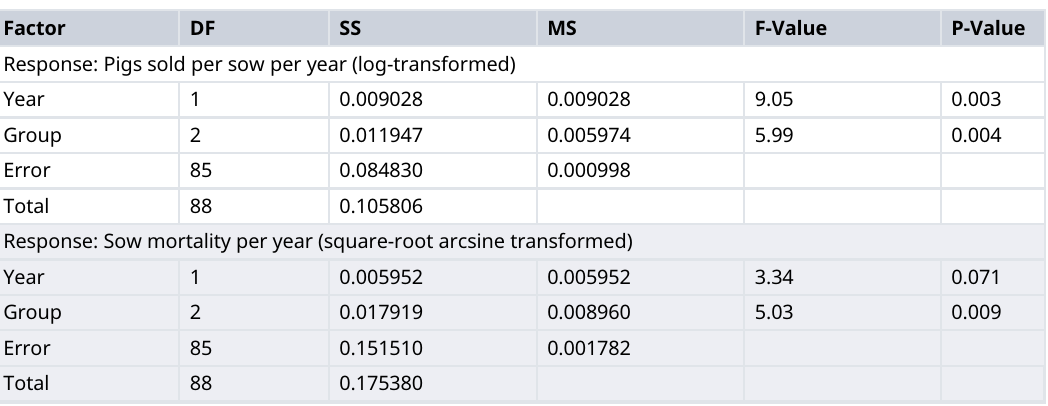
Table 1. Results of general linear models testing the influence of housing groups (CRATE, RESTRICTED, BANNED) on each of the response variables (pigs sold per sow per year, and sow mortality per year) controlling for variations across